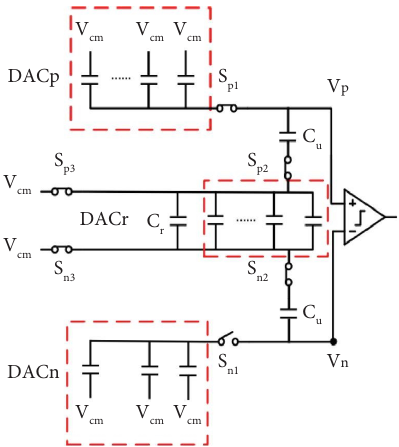
Figure 18: Te capacitance multiplexing technique [56].